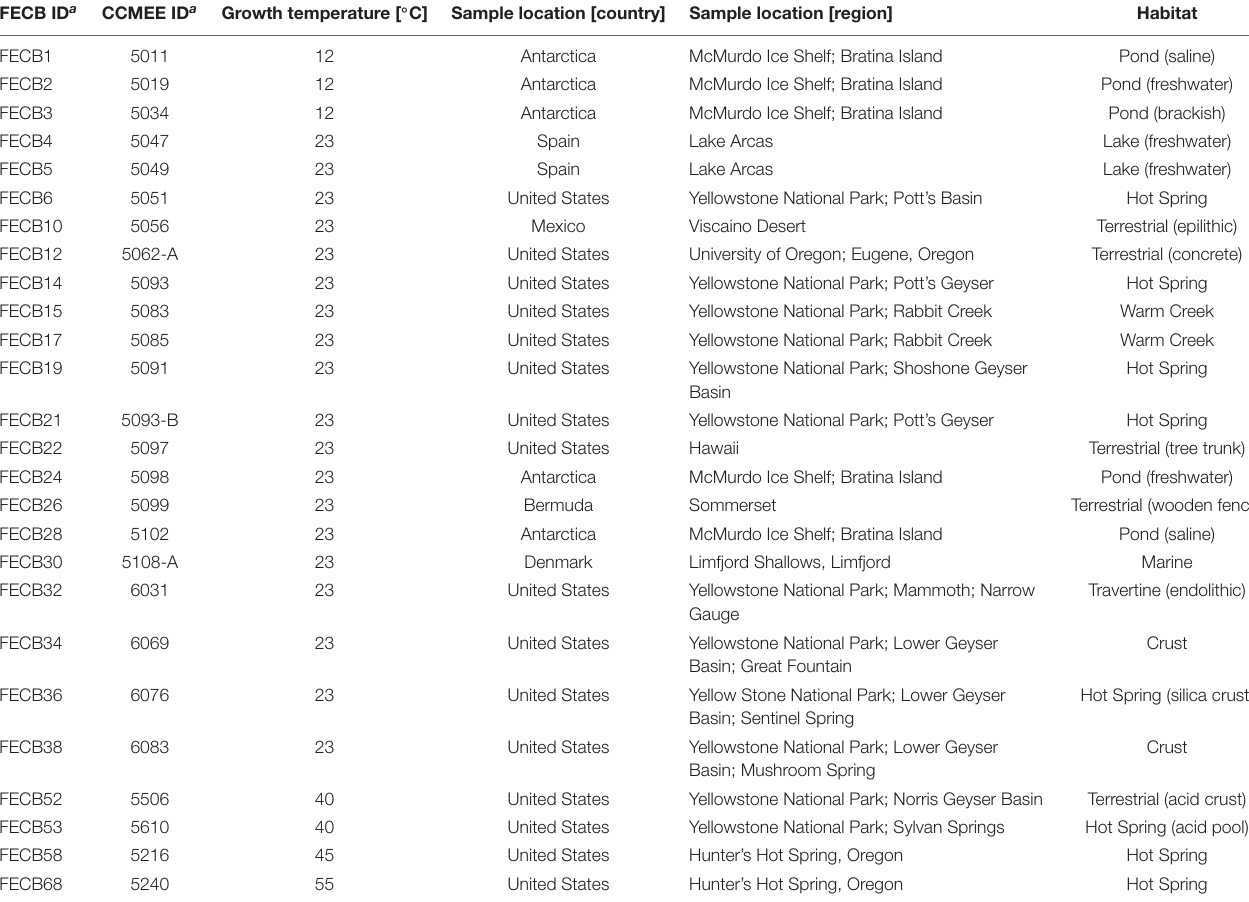
TABLE 1 | Summary of photosynthetic co-cultures for which 16S rRNA gene profiles were